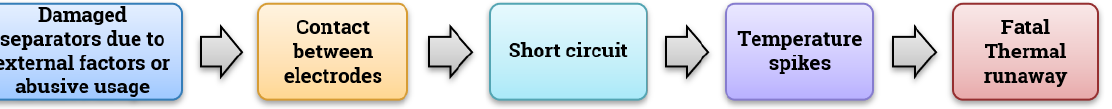
Figure 7. Separator failure mechanism.